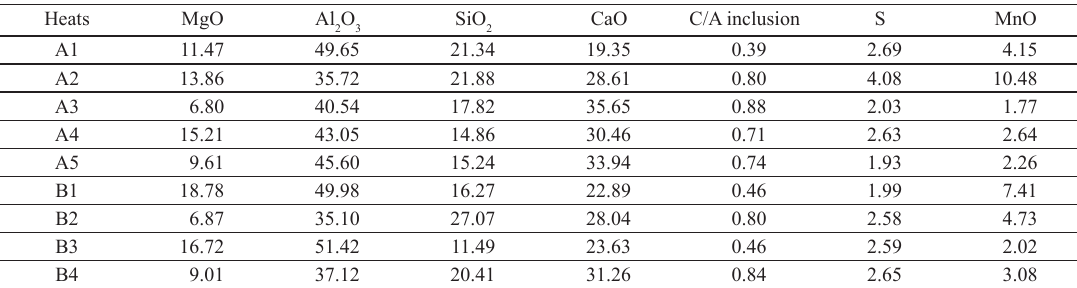
Table 2. Average inclusion composition (samples X2) in tundish (mass%).